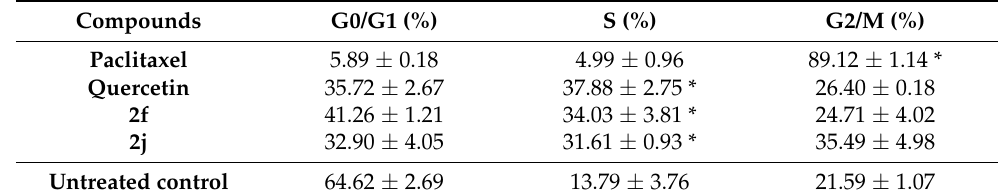
Table 4. Percentage of population in each cell cycle phase after treatment with quercetin, 2f , and 2j in HeLa cells.